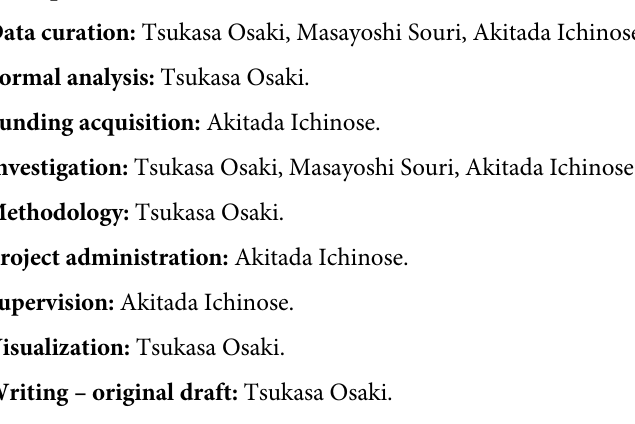
S9 Table. FXIII inhibitors and anti-FXIII autoantibody levels measured by ELISA and ICT in each genotypes except for MHC class I and II molecules and their associated genes. If variant allelic frequency compared with database was significantly high, the term “High” was described in column 1. If the frequency was significantly low, the term “Low” was described in column 1. The missing value are displayed in a gray